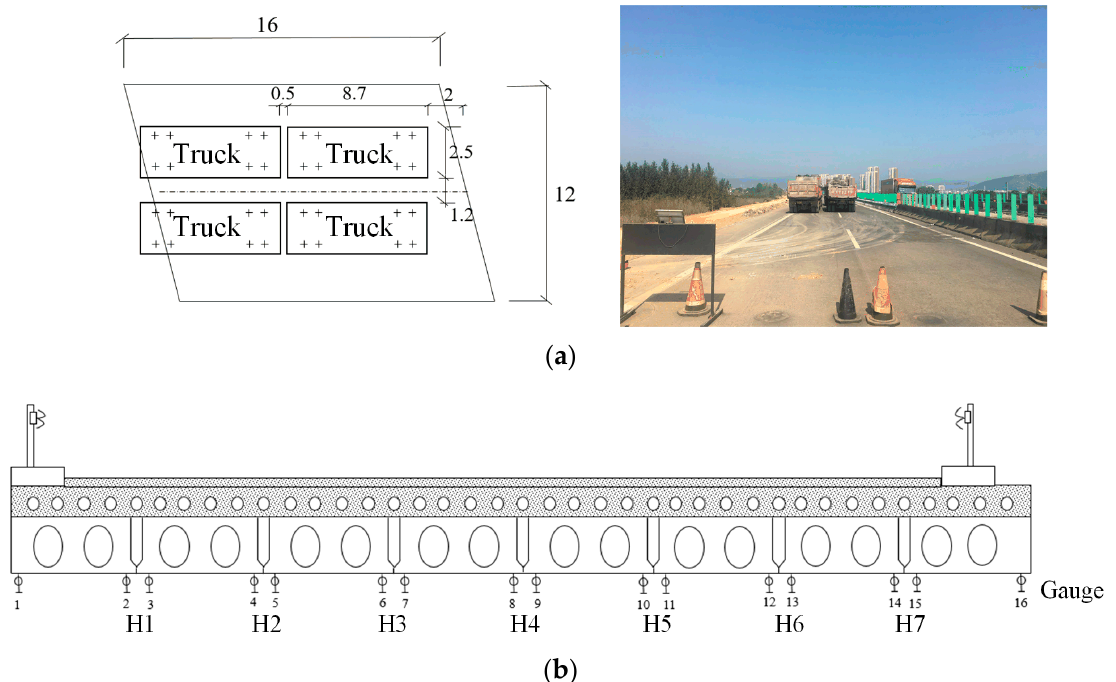
Figure 2. Layout of the load test: ( a ) truck load; ( b ) measuring point.